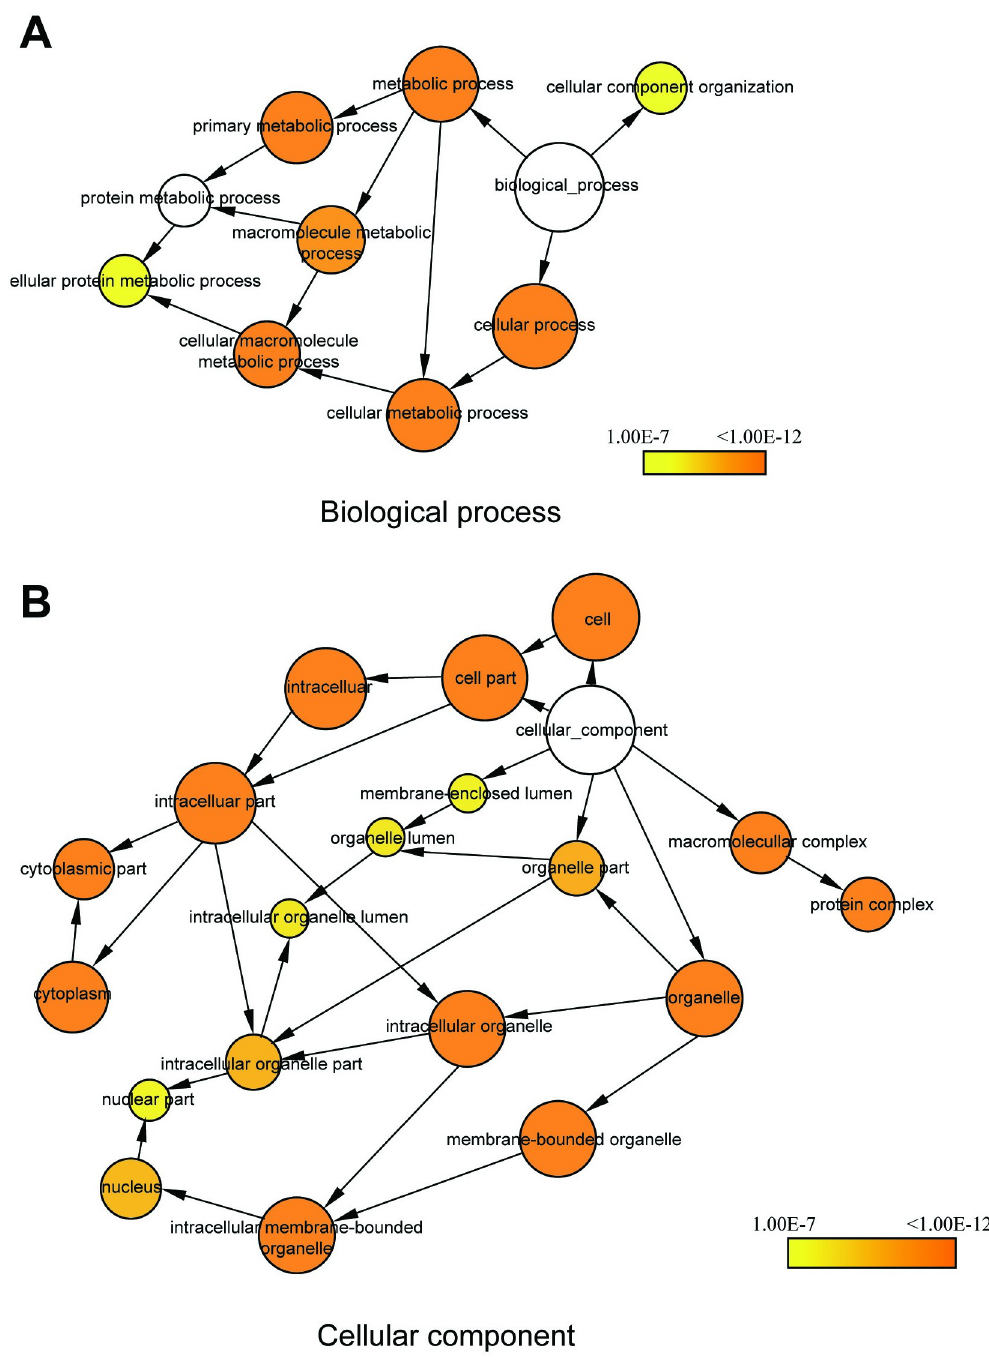
Fig 5. Gene ontology analysis of TMOD1 regulation network. Protein-protein interaction network was constructed using 83 dysregulated proteins in BisoGenet plugin of Cytoscape (v.3.6) and GO analysis were performed on the network using BiNGO plugin. The clusters of biological process (A) and cellular component (B) were shown. The color gradient of the cluster distribution network stands for the p -value of each cluster associated with the term. Darker (orange) color indicates a lower p